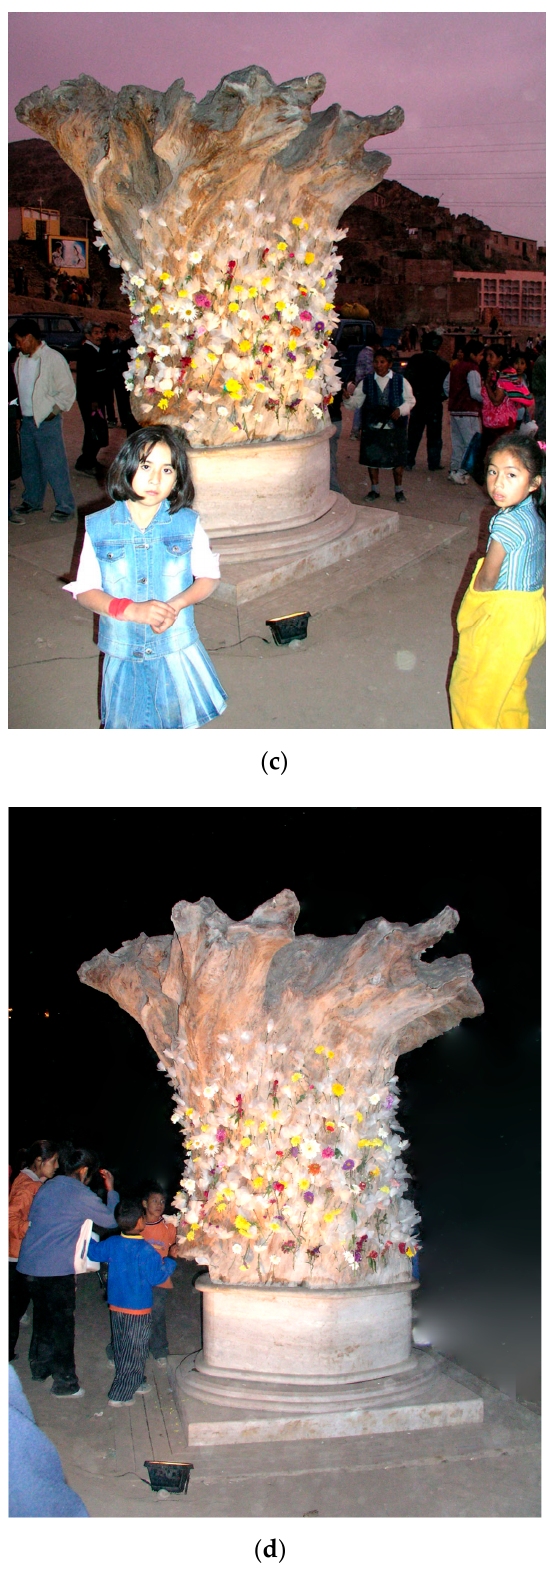
Figure 2. ( a – d ) Carmen Reátegui, Árbol , Cementerio Nueva Esperanza, Lima, 2004. Photographs published with permission of the artist.